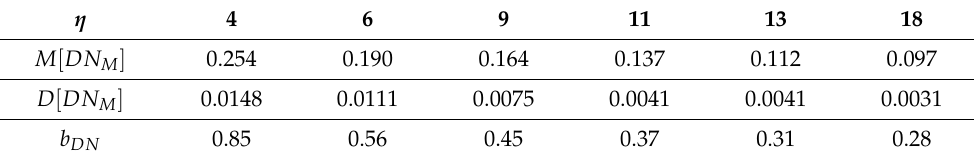
Table 8. Values of M [ DN M ] and D [ DN M ] depending on the sample